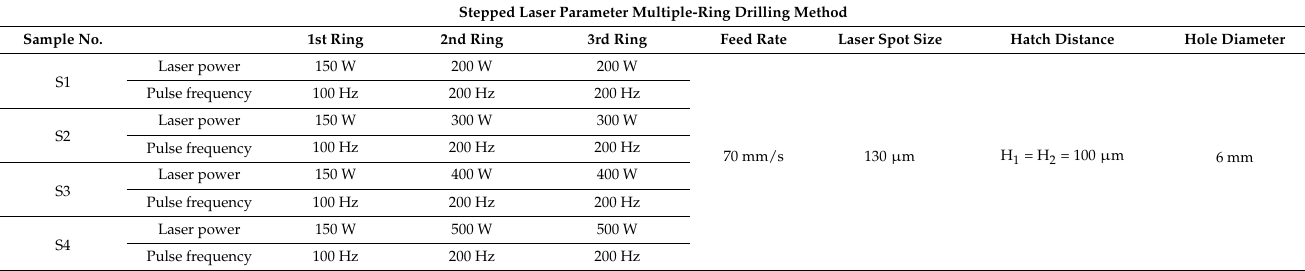
Figure 2. Schematic diagram of different laser drilling methods: ( a ) single ring; ( b ) multiple rings. Table 1. Laser processing parameters for the stepped laser parameter multiple-ring drilling method.